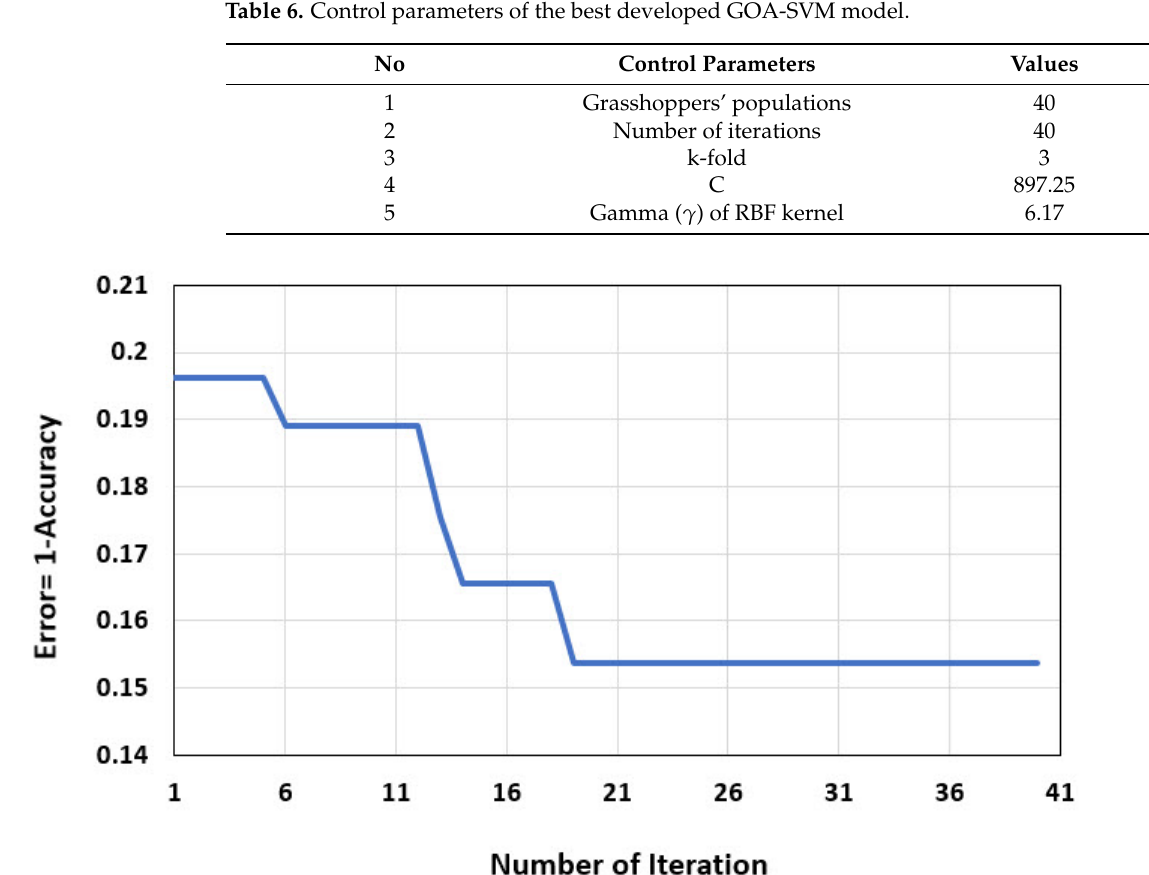
Figure 6. Variations of error value in each iteration during GOA-SVM modeling.